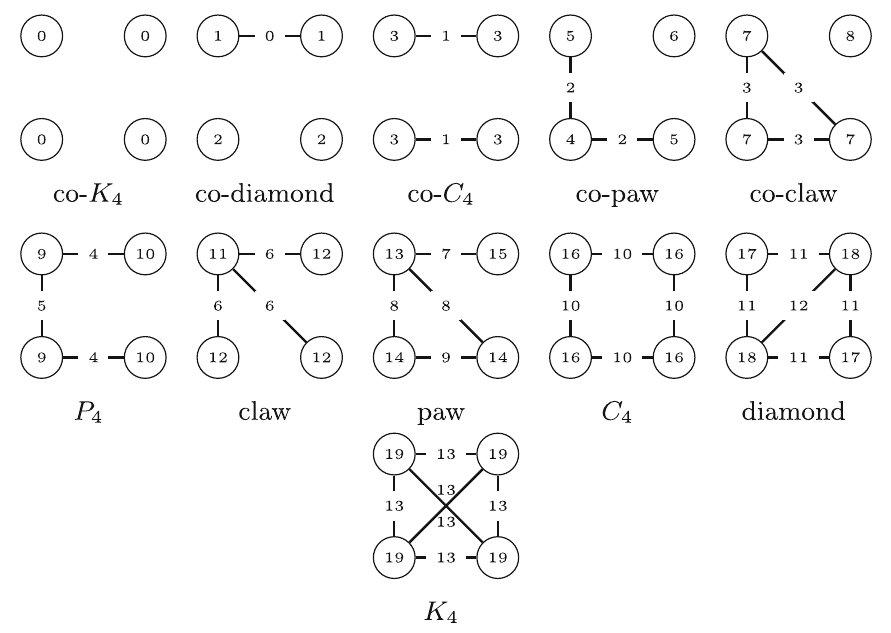
Fig. 1 All non-isomorphic subgraphs with four nodes (quads). Node and edge labels refer to the orbits and were enumerated such that each orbit is identified with a single